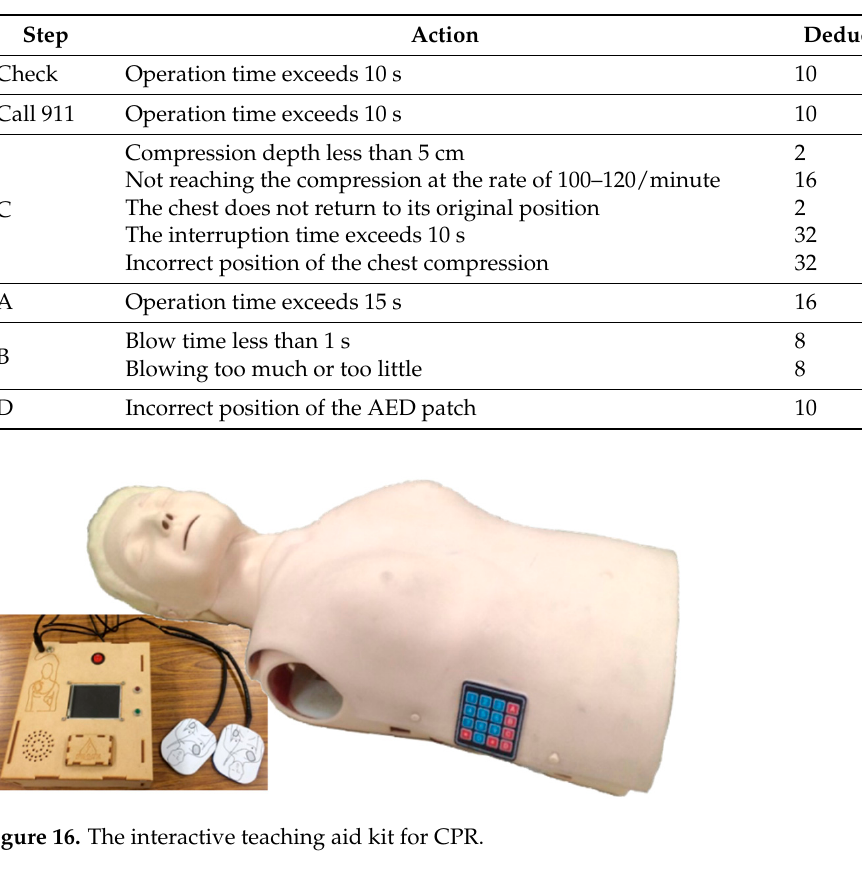
Table 1. The score sheet of the assessment mode.